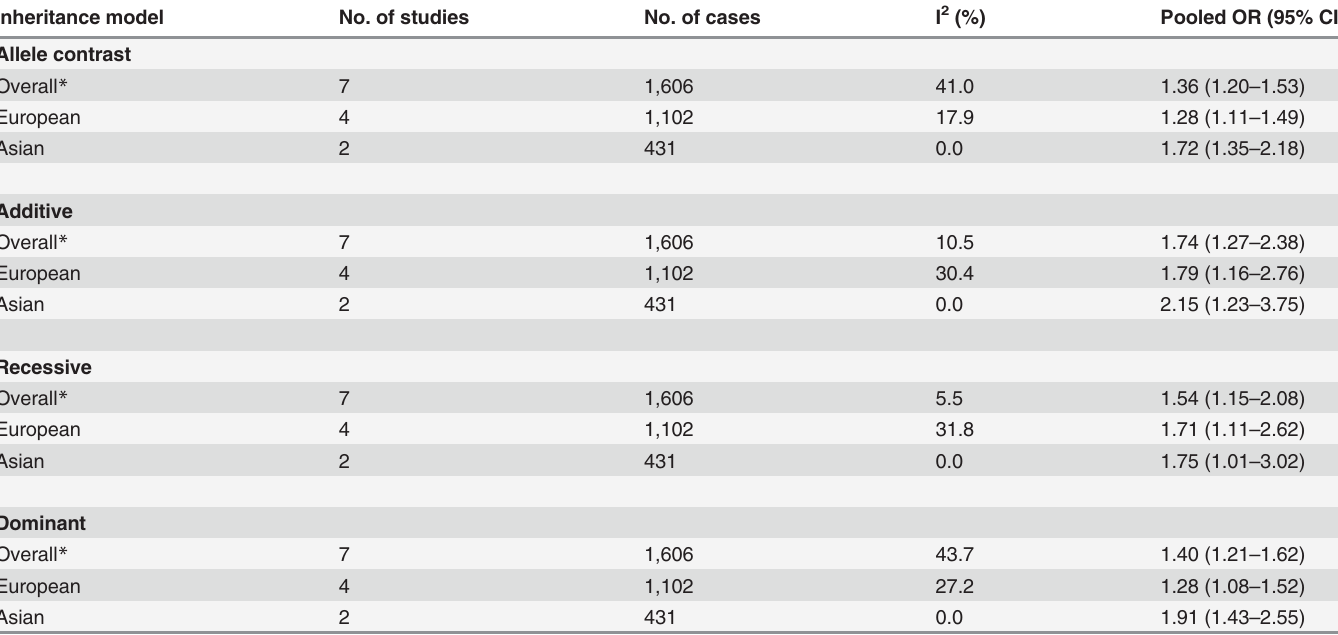
Table 2. Pooled measures for association between the ENPP1 K121Q polymorphism and susceptibility to diabetic kidney